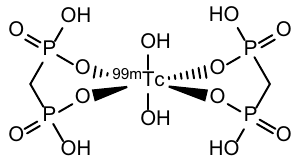
Fig. 7 Molecular structure of bone scan agent [ 99m